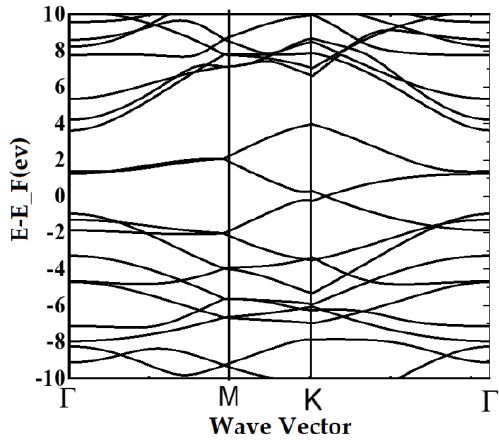
Figure 6. The band structure of BC 2 N.